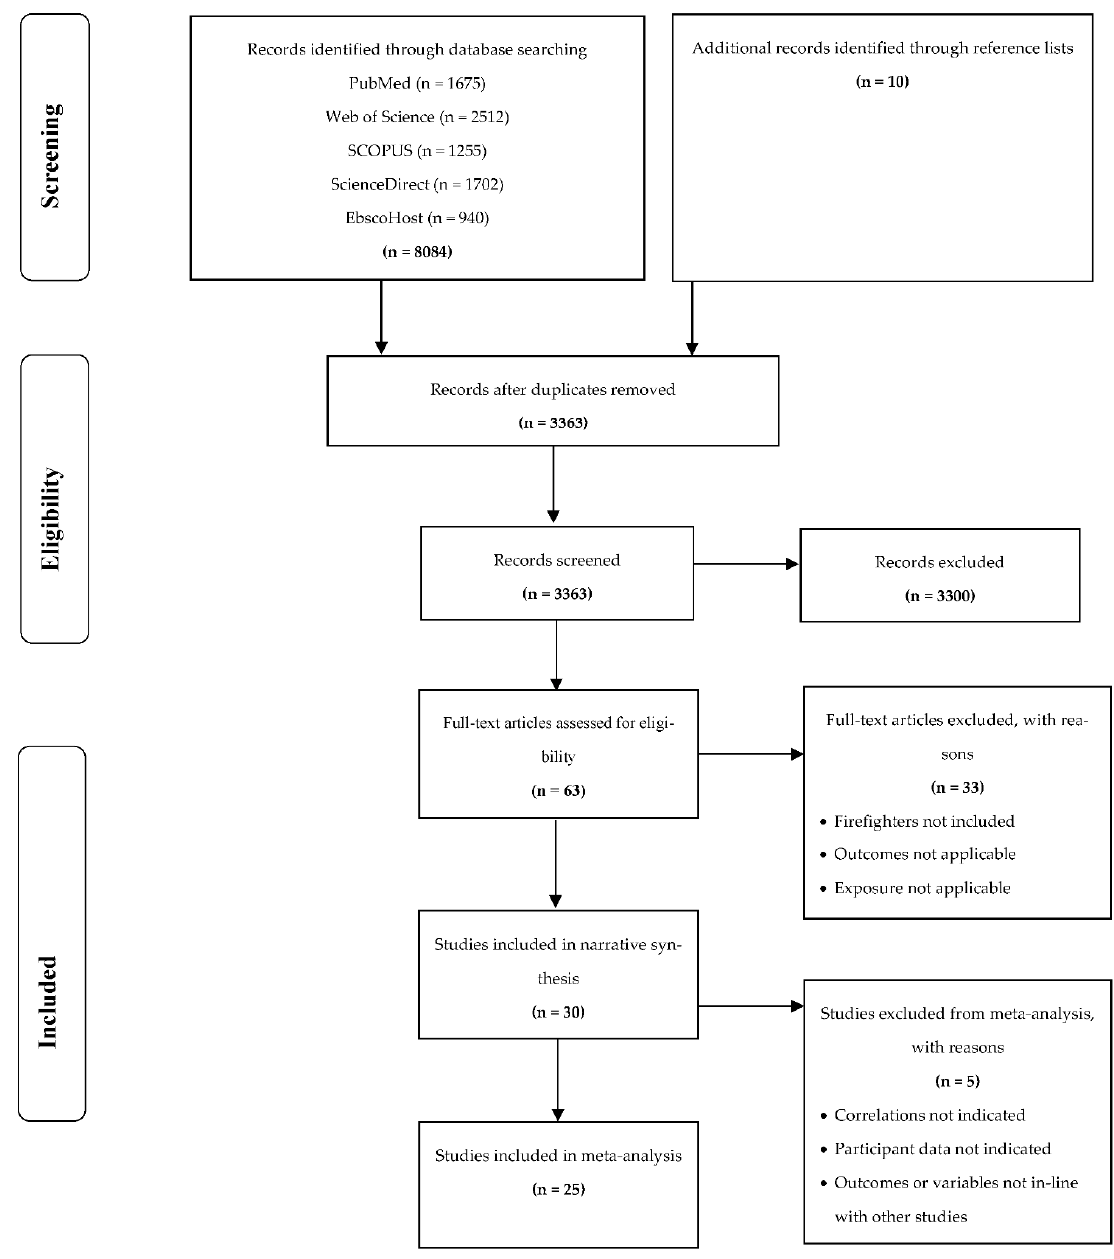
Figure 1. Flow chart of study selection in narrative review: Adapted from Moher et al. [54].